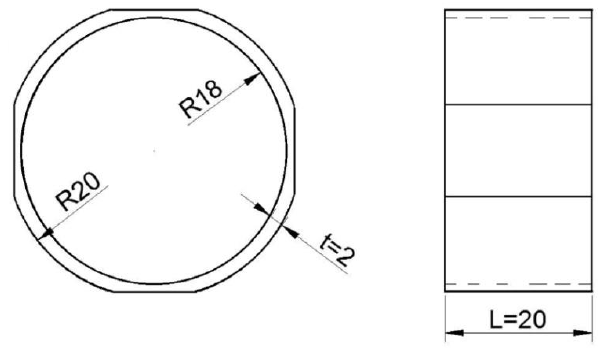
Figure 2. Schematic view of the thin-walled cylinder.